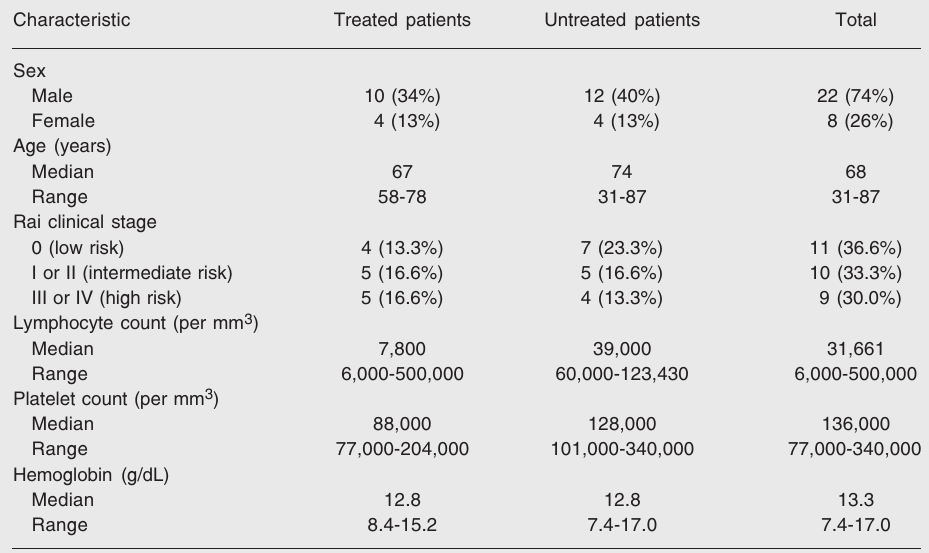
Table 1. Characteristics of the 30 patients according to previous treatment at the time of analysis. Characteristic Treated